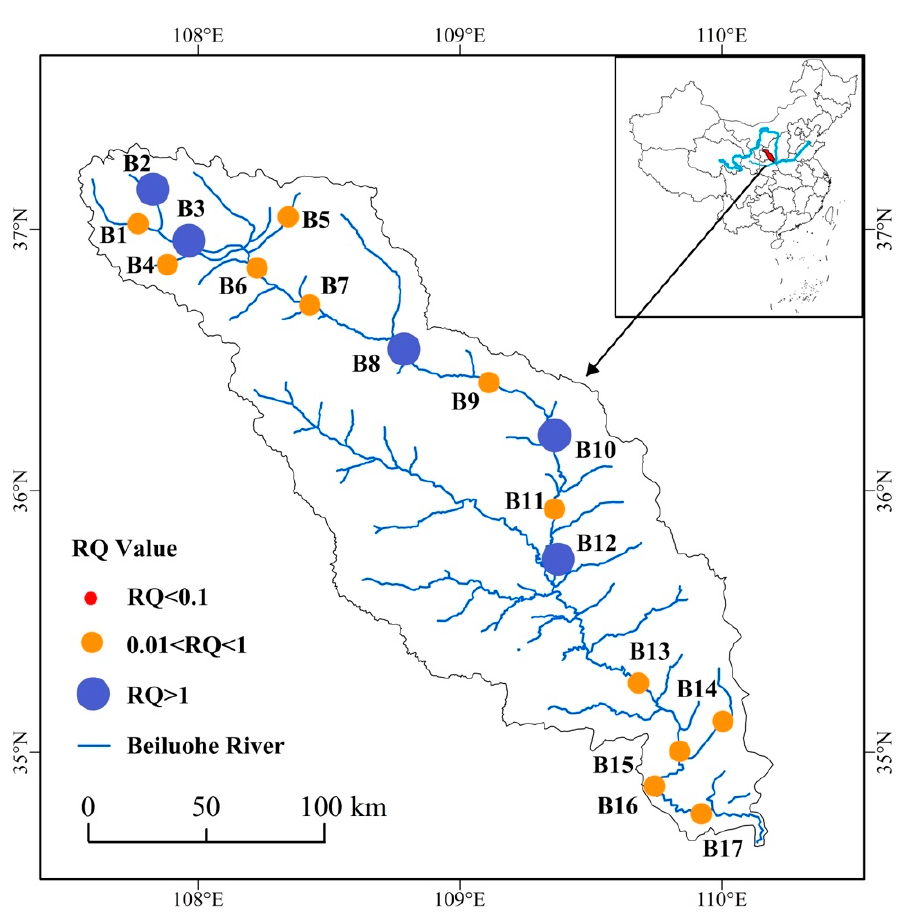
Figure 3. The risk quotient (RQ) of PCBs in all sampling sites.